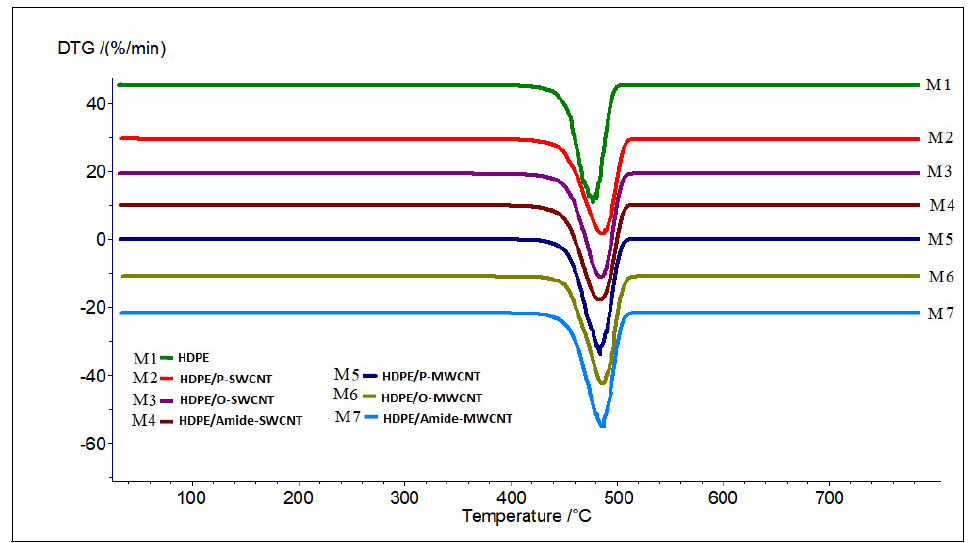
Figure 4. DTG degradation graphs for the nanocomposite sheets M1 – M7 performed with heating rate of 10 °C/min from 25 °C to 800 °C in nitrogen atmosphere.